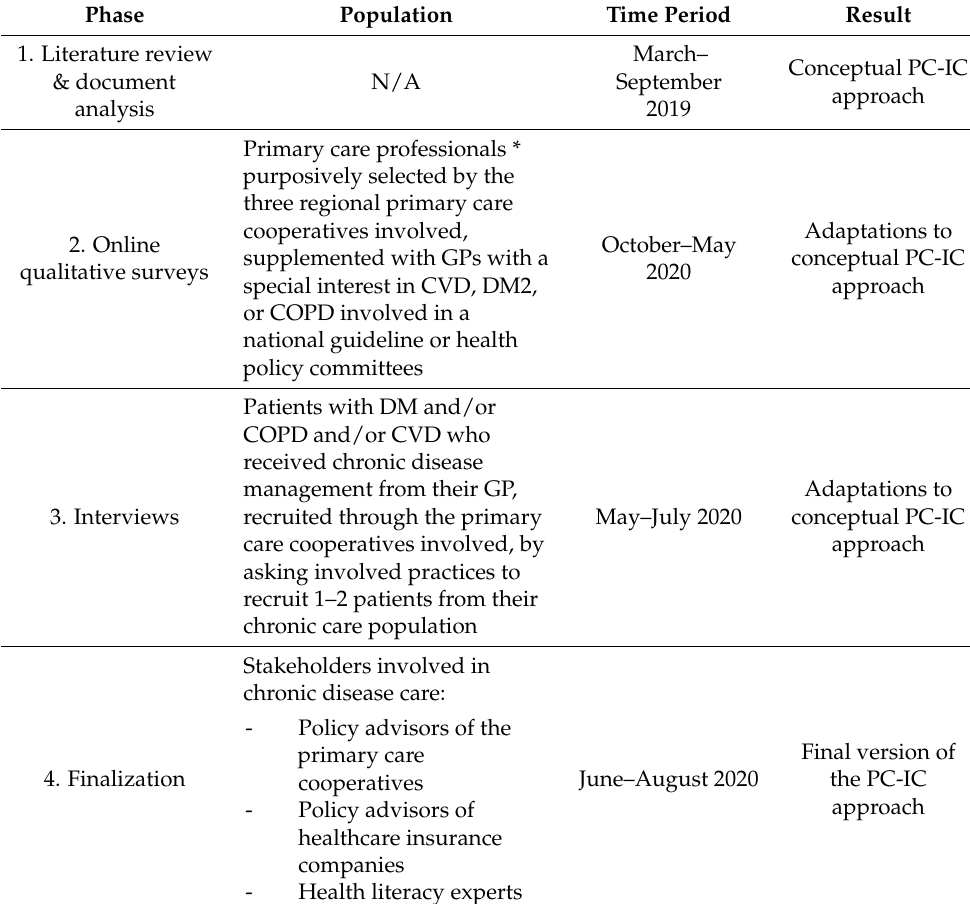
Table 1. Overview of the timing and results of the subsequent phases in the development of the patient-centred integrated care